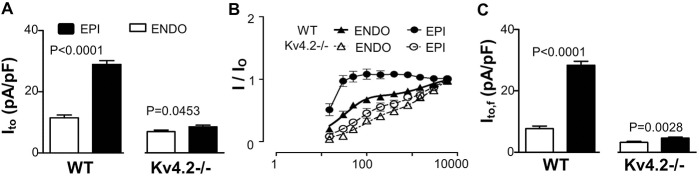
Heterogeneity of Ito and Ito,f in left ventricular free wall cardiomyocytes in WT and Kv4.2-/-.(A) This shows the average Ito density (Ito = Ito,f + Ito,s) estimated in EPI and ENDO cardiomyocytes isolated from WT and Kv4.2-/- hearts (n = 12 for all groups) using the tri-exponential fitting protocol (described in Fig 1). As we can see, Ito density in Kv4.2-/- was reduced compared to WT for both ENDO and EPI cardiomyocytes. What is striking here is that the transmural gradients of Ito (EPI/ENDO) exist in left ventricular free walls for both WT and Kv4.2-/- but this gradient is markedly reduced in the Kv4.2-/- compared to WT. (B) Again Ito recovery from inactivation curve (n = 12 in each group) was used to separate Ito,f and Ito,s in Ito using the method described in Fig 2. (C) This panel quantifies the Ito,f measured in ENDO and EPI cardiomyocytes from WT and Kv4.2-/- hearts (n = 6 for all groups).